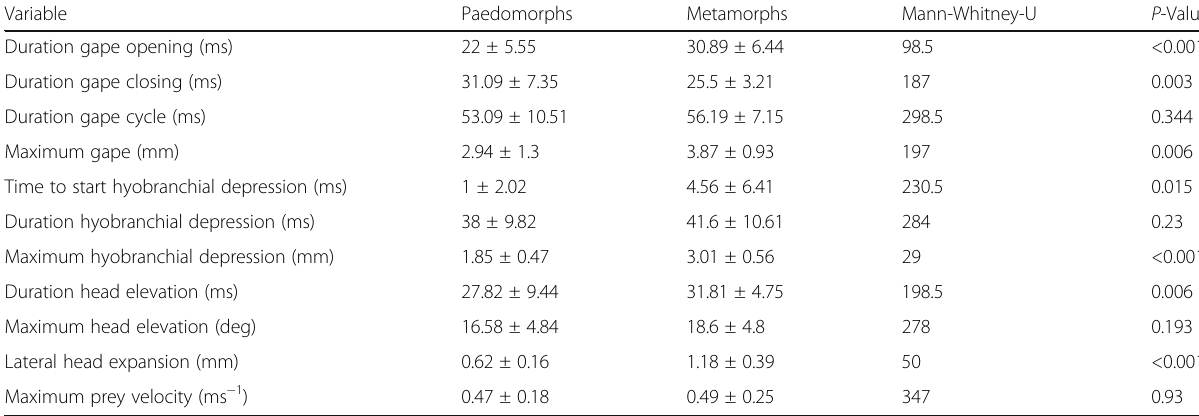
Table 1 Kinematic variables and series of Mann-Whitney-U tests comparing paedomorphic and metamorphic Alpine newts. Significance level was adjusted to p ≤ 0.0046 after simultaneous Bonferroni correction